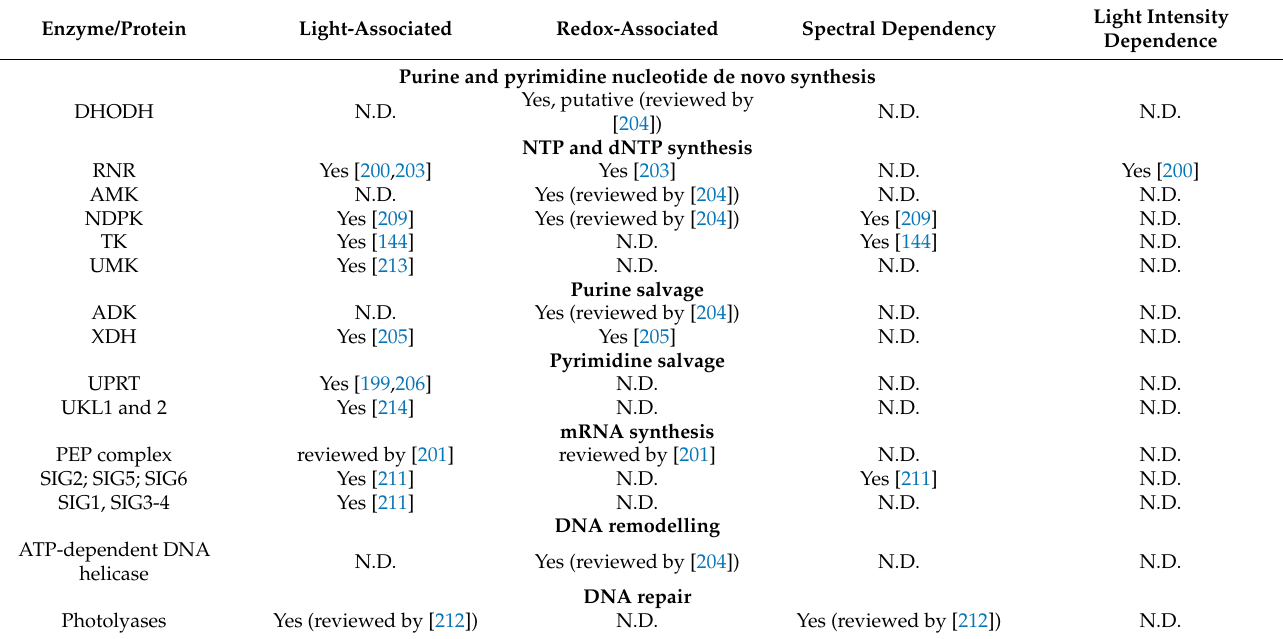
Table A3. Light- and/or redox-associated regulation of proteins involved in nucleotide or nucleic acid